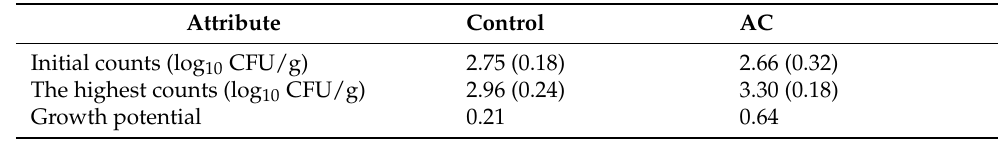
Table 3. L. monocytogenes growth potential in control (produced with the addition of nitrite) and alternatively cured (AC) sausages (mean values and standard deviation in the